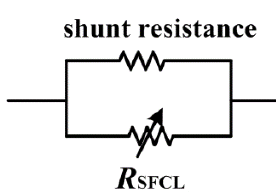
Figure 1. Structure of the resistive superconductive fault current limiter